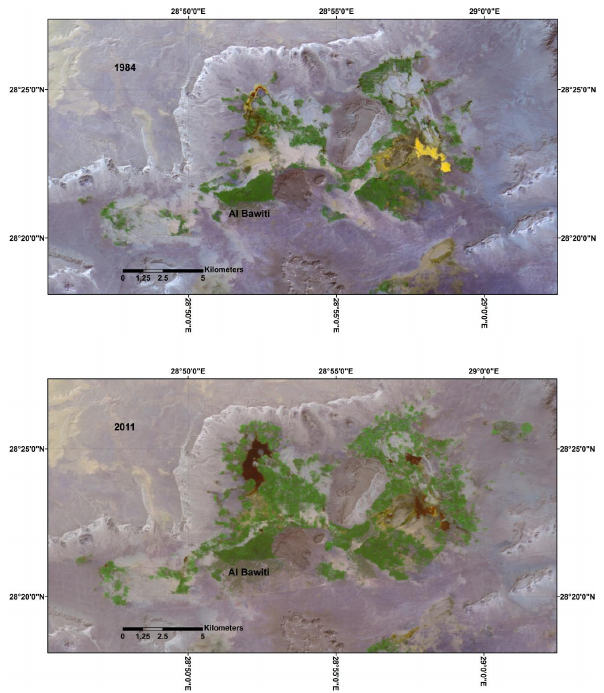
Fig. 4. The land cover changes within the Baharia Oasis between 1984 and 2011. Note the development of water ponds (black) on the low lying playas (yellow), and also note that the green colours represent the cultivated areas.